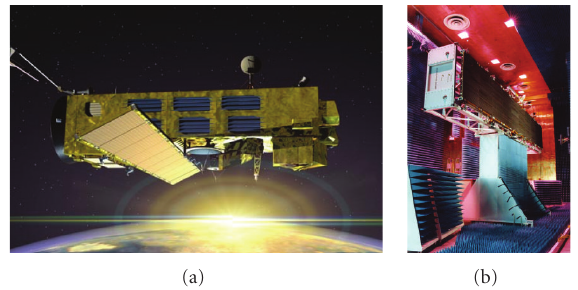
Figure 13: Pictorial view of the ASAR antenna on ENVISAT and in near